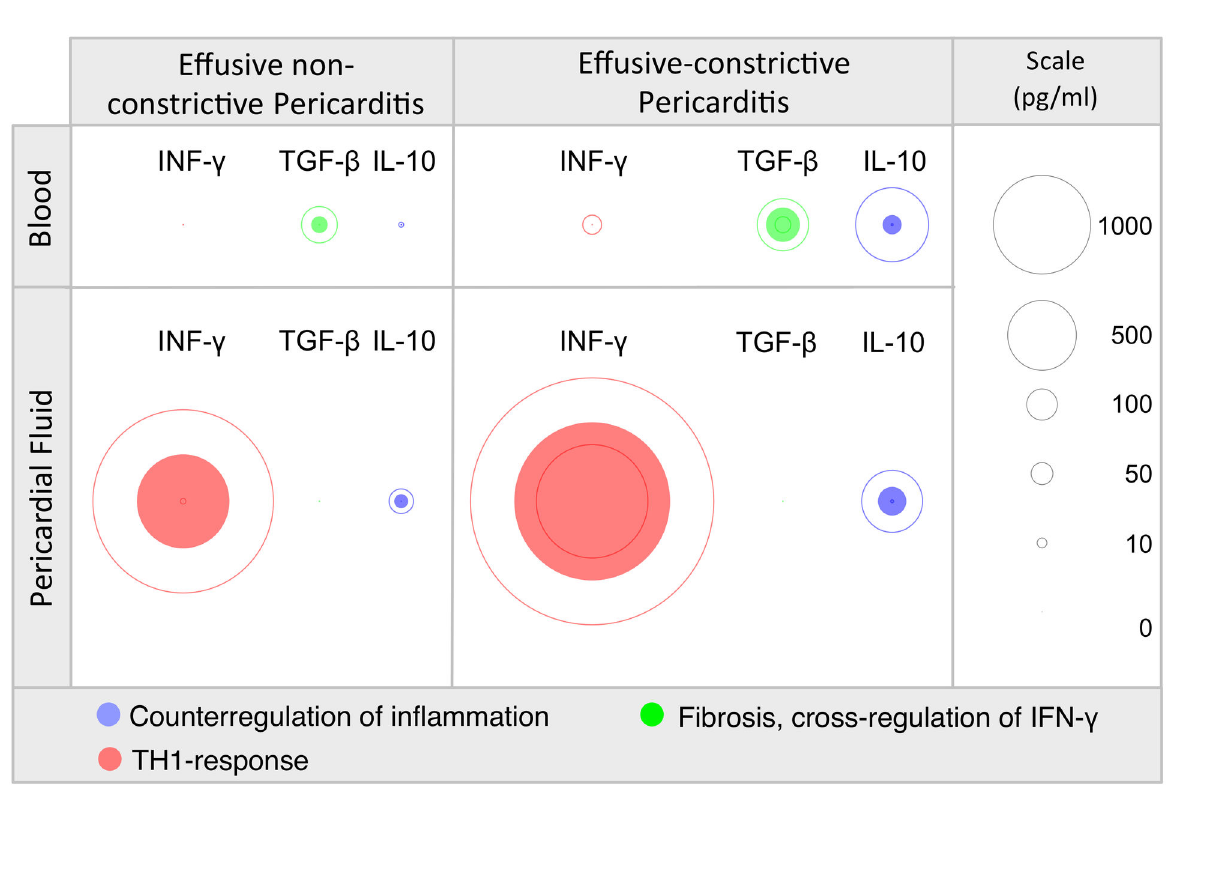
Figure 1. Visual representation of significant cytokine differences when comparing effusive with effusive-constrictive tuberculous pericarditis in the blood and pericardial fluid compartments (see Table 2 for results of all cytokines). Each colored disc represents the median value for the particular cytokine; the areas are proportional to the concentration of the cytokine. IL-10, interleukin 10; TGF- β, transforming growth factor beta; IFN- γ , interferon gamma.